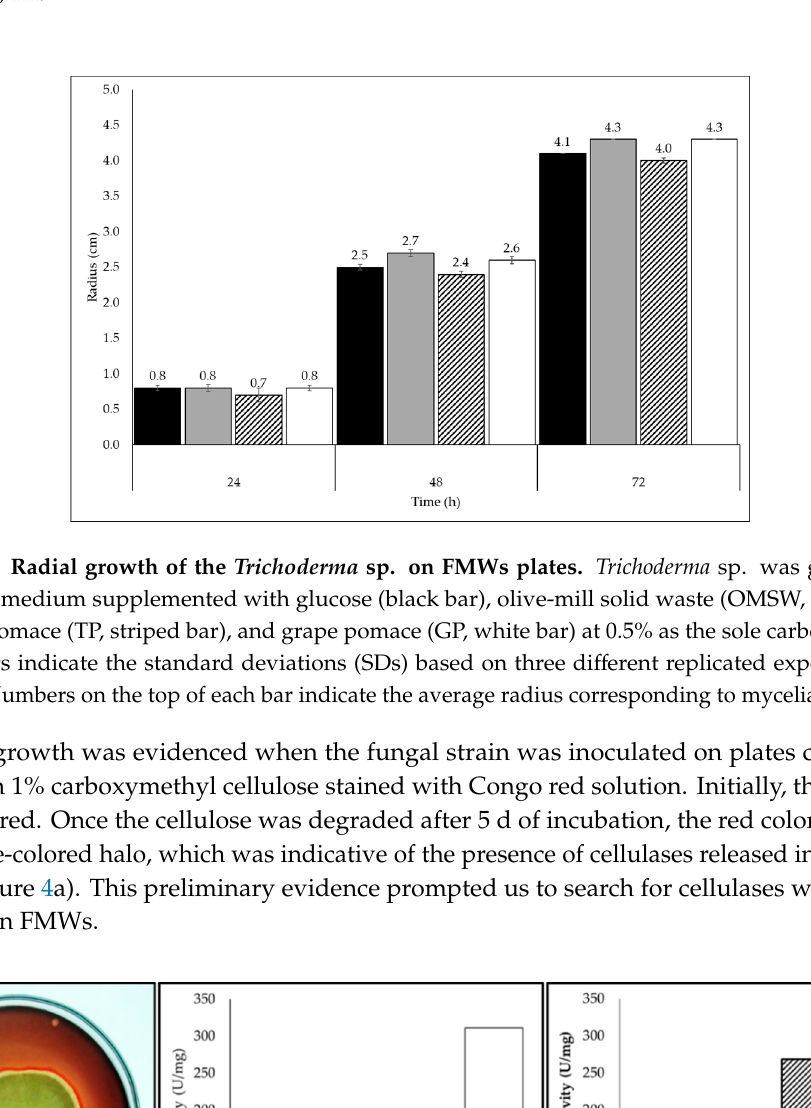
Figure 3. Radial growth of the Trichoderma sp . on FMWs plates. Trichoderma sp. was grown on Mandels medium supplemented with glucose (black bar), olive-mill solid waste (OMSW, gray bar), tomato pomace (TP, striped bar), and grape pomace (GP, white bar) at 0.5% as the sole carbon source. Error bars indicate the standard deviations (SDs) based on three different replicated experimental values. Numbers on the top of each bar indicate the average radius corresponding to mycelial growth.